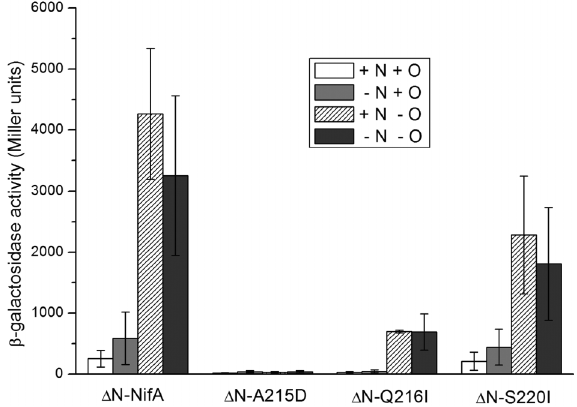
Figure 3. Transcriptional activity of D N-NifA mutant proteins in Escherichia coli JM109 (DE3) carrying pRT22 ( nifH::lacZ ). D N-NifA indicates NifA lacking 203 amino acid residues at the N-terminal GAF domain. D N-215D, D N-Q216I, and D N-S220I indicate the N-truncated forms of NifA mutants. b -galactosidase expression experiments were performed in NFDM medium supplemented with 20 mM ammonium chloride ( + N) or 0.2% casamino acids ( – N) in the presence ( + O) or absence ( – O) of O 2 . Data are reported as the mean±SD of 3 independent assays. b -galactosidase activity is reported as Miller units.